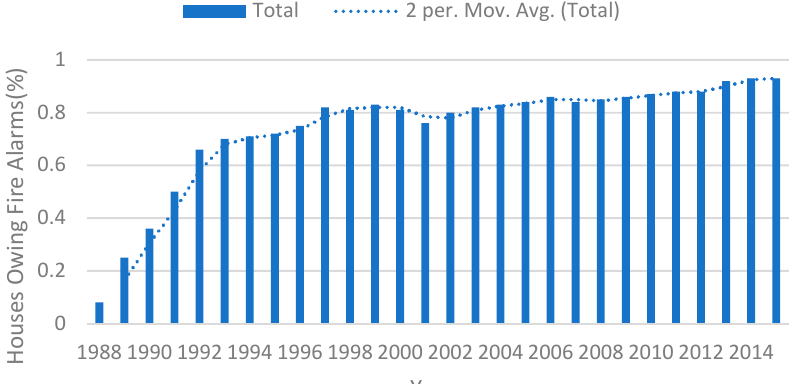
Figure 1. Percentage of houses owing fire alarms per year.